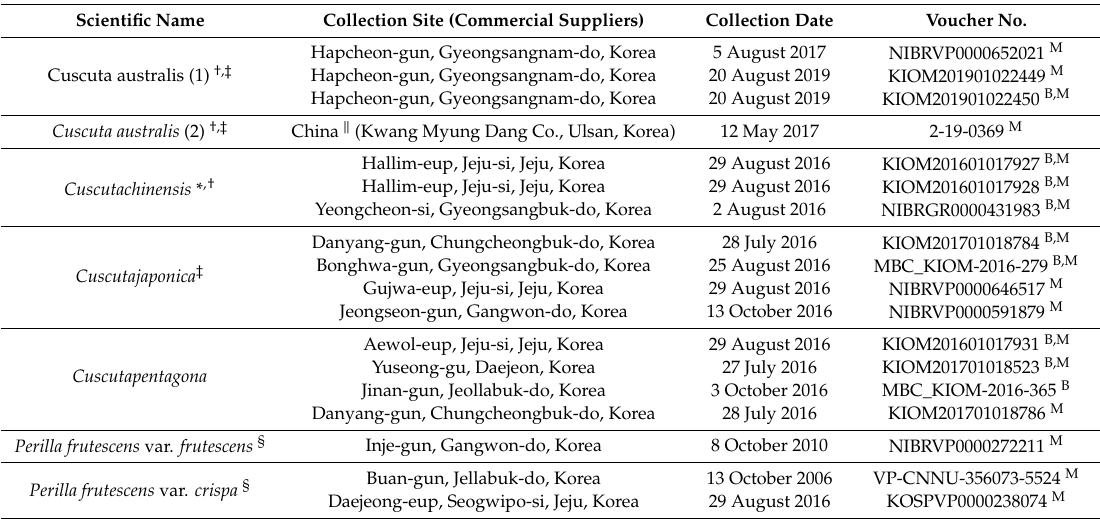
Table 5. List of plant species used in this study along with the collection site, collection date, and voucher